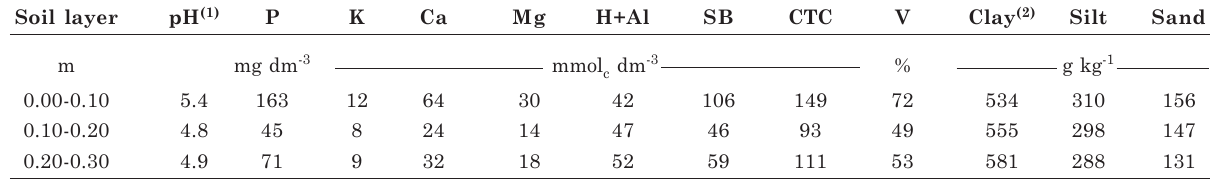
(1) Raij et al. (2001); (2) Pipette method at low rotation (Camargo et al.,